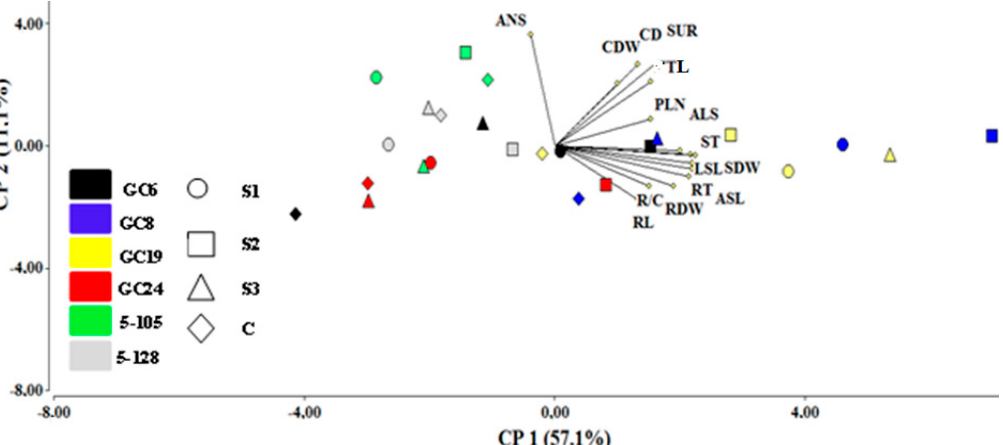
Figure 1. Principal component analysis plot. References: ANS (Average number of shoots), CDW (cutting dry weight), CD (cutting diameter), SUR (survival), TL (total leaves), PLN (primary leave number), ALS (average amount of leaves per shoot), ST (shoot type), LSL (longest shoot length), SDW (shoot dry weight), RT (root type), ASL (average shoot length), R/C (roots/callus), RDW (radicular dry weight), RL (root length).